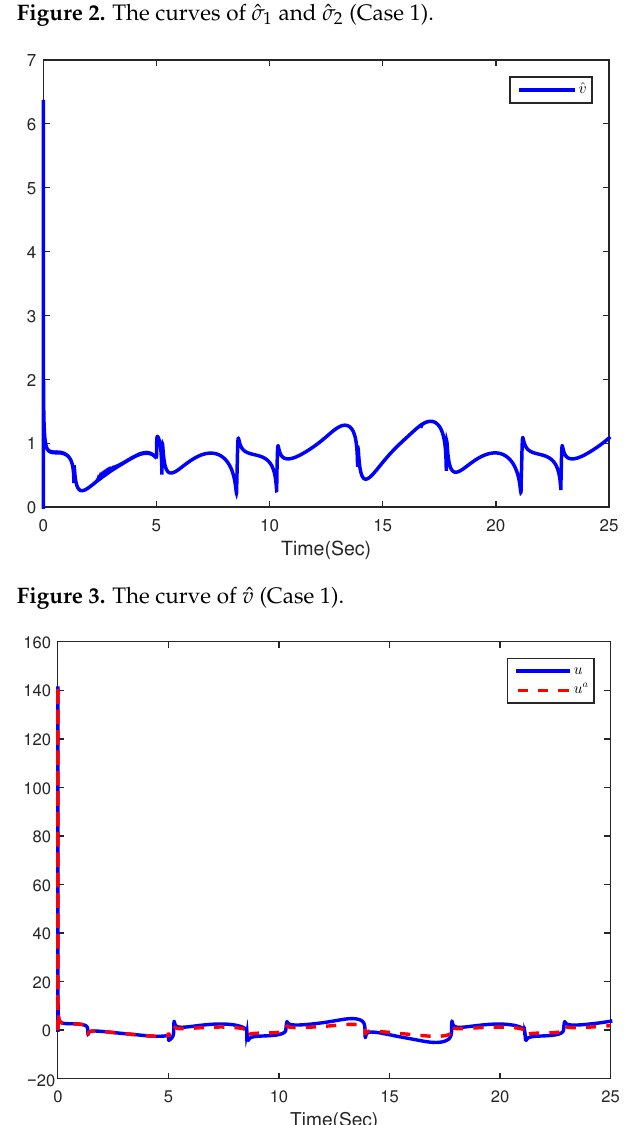
Figure 4. The control input u a (Case